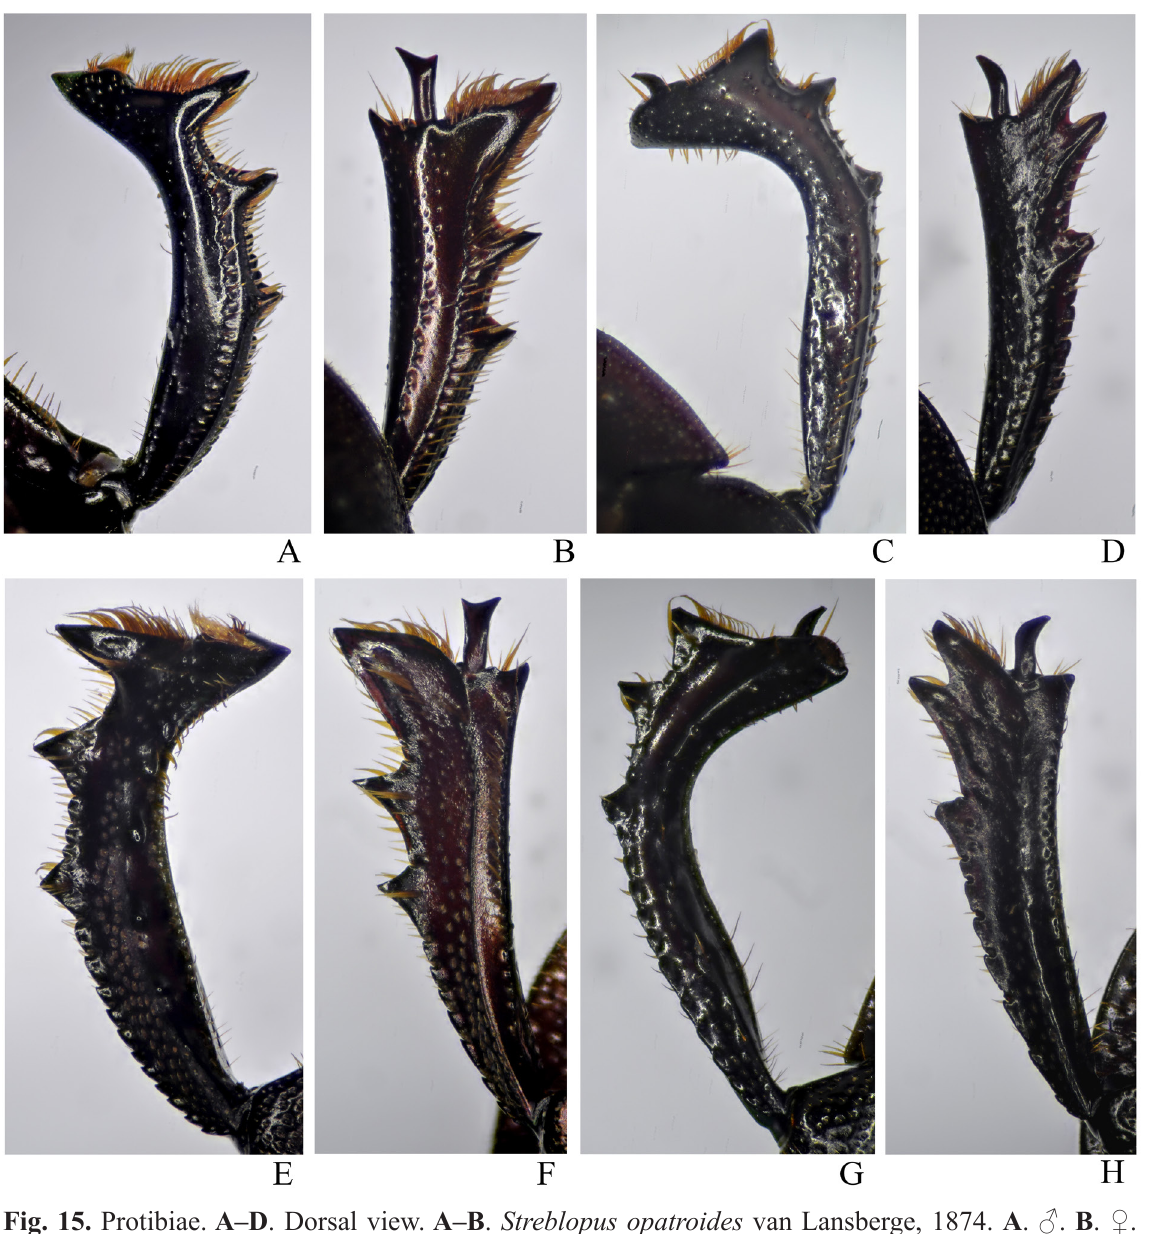
Fig. 15. Protibiae. A‒D . Dorsal view. A‒B . Streblopus opatroides van Lansberge, 1874. A . ♂. B . ♀. C‒D . S. punctatus (Balthasar, 1938). C . ♂. D . ♀. E‒H . Ventral view. E‒F . S. opatroides . E . ♂. F . ♀. G‒H . S. punctatus . G . ♂. H . ♀. Notice the many differences between the species and sexes, in particular the presence of a protibial spur in males of S. punctatus (and its absence in S. opatroides ) and the different shapes of the spurs and of the lateral teeth in females of the two